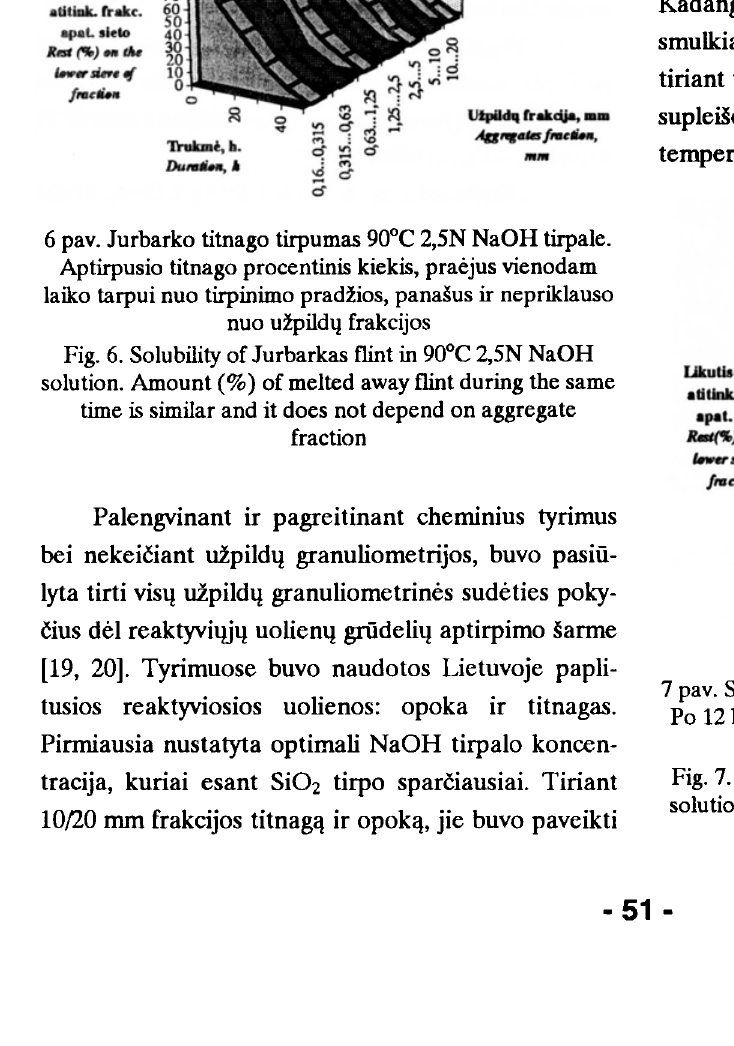
Fig. 7. Solubility of Stonishkiai gaize in 90°C 2,5N NaOH solution. After 12 h treatment gaize grains of all fractions fall out from corresponding lower